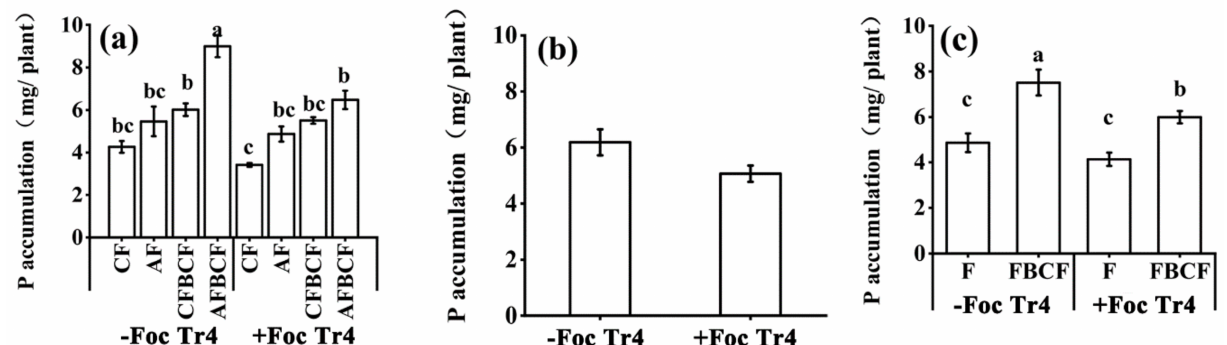
Figure 6. Effects of alkaline fertilizer and biocontrol fungi on P accumulation of banana 60 days after Foc Tr4 inoculation. ( a ) Effect of each treatment on P accumulation. ( b ) Effect of inoculation of pathogen (main plots) on P accumulation. ( c ) Effect of biocontrol fungi (sub-plots) on P accumulation. Different letters on the top of the bars indicated significant difference ( p < 0.05) among the treatments. CF stands for conventional fertilizer. AF stands for alkaline fertilizer. CFBCF stands for conventional fertilizer and biocontrol fungi. AFBCF stands for alkaline fertilizer and biocontrol fungi.